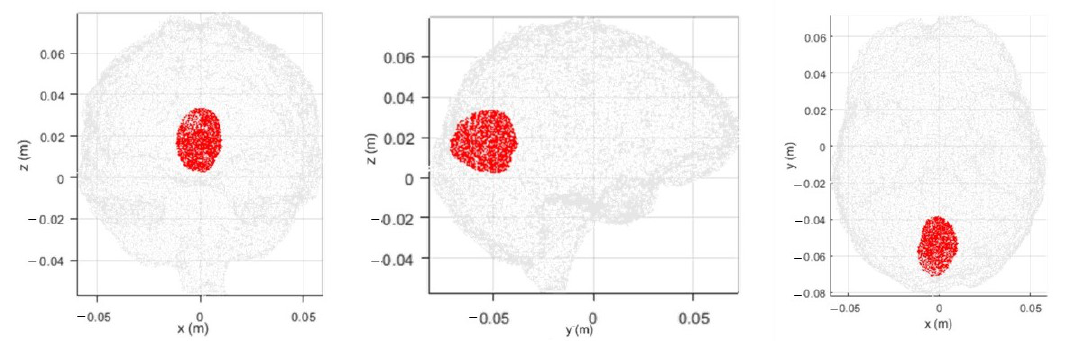
Figure 5. Views of the considered hemorrhagic stroke (in red) within the brain.